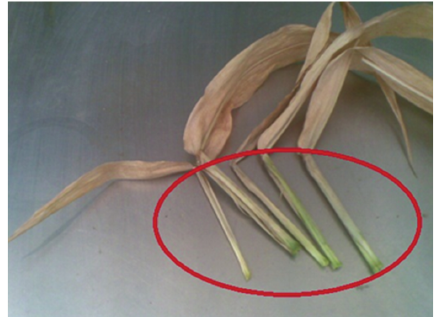
Figure 1: Sheaths (inside the ellipse) and laminas (outside the ellipse) of maize